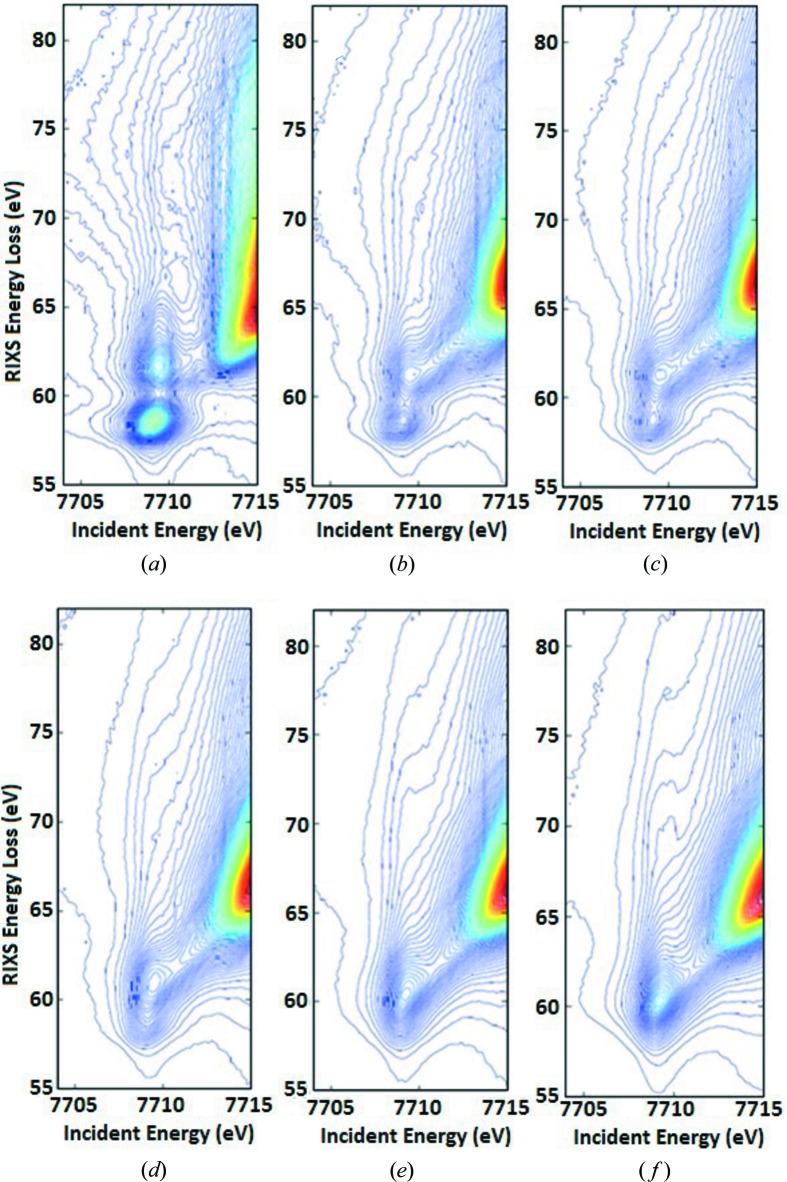
The experimental Co 1s3p RIXS data of Co–Mo/Al2O3. The freshly calcined sample was measured at 25°C (a). Subsequently we used gradual sulfidation by heating the sample under a dynamic 10% H2S/H2 gas mixture flow to 25°C (b), 70°C (c), 110°C (d), 150°C (e), and 400°C (f).